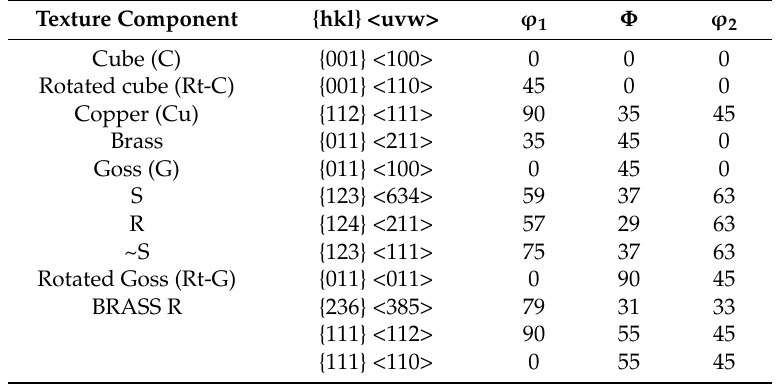
Table 6. Miller indices and Euler angles for common texture components in cubic-crystal